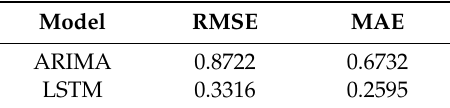
Figure 5. Out of sample prediction from ARIMA and LSTM. Table 4. Root mean square error and mean absolute error results of LSTM and ARIMA on “Out of sample” predictions.